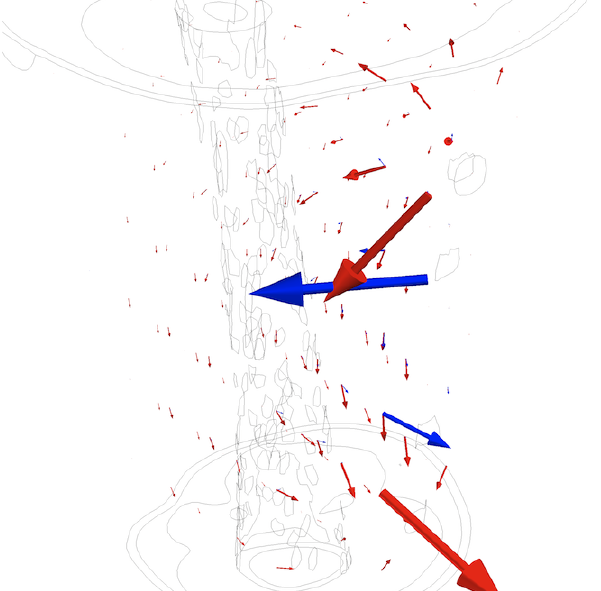
Fig. 27: Plot of current densities for normal (red) and reciprocal (blue)